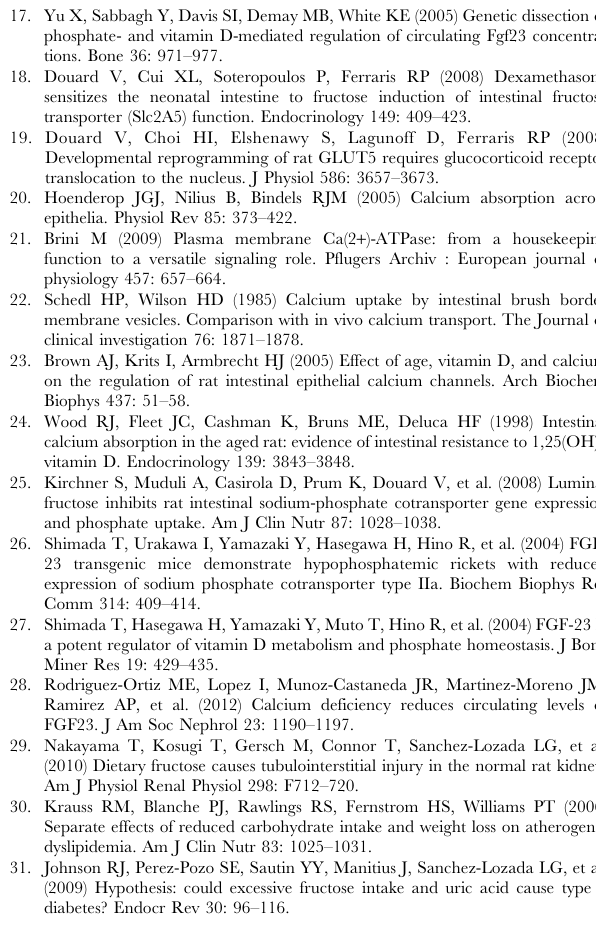
Figure S2 The body weight, feeding rate, and kidney weight of mice fed diets containing normal Ca 2 + and 63% glucose, fructose or starch. A ) Body weight after 3 mo of feeding on the special diets. B ) Feeding rate per day normalized to body weight. C ) Kidney weight after 3 mo of feeding on the special diets. D ) Kidney somatic index. Bars are means 6 SEM; n = 5–8. Differences ( P , 0.05) among means are indicated by differences in superscript letters, as analyzed by 1-way ANOVA LSD. Thus, bars with superscript ‘‘a’’ are . bars with ‘‘b’’. (TIF) Figure S3 The body and kidney weight of rat fed diets containing either 43% glucose or fructose. A ) Body weight after 3 mo of feeding of the special diets. B ) Feeding rate per day normalized to body weight. C ) Kidney weight after 3 mo of feeding of the special diets. D ) Kidney somatic index. Bars are means 6 SEM; n =5–8. Differences ( P , 0.05) among means are indicated by differences in superscript letters, as analyzed by 1-way ANOVA LSD. Thus, bars with superscript ‘‘a’’ are . bars with ‘‘b’’. Figure S4 CaBP9k protein abundance. The protein abundance of CaBP9k was determined in the small intestine of mice fed diets containing either 43% glucose or fructose, in combination with either normal or low Ca 2 + . b -actin was used as a reference. Nor = normal; G = glucose; F = fructose. (TIF)